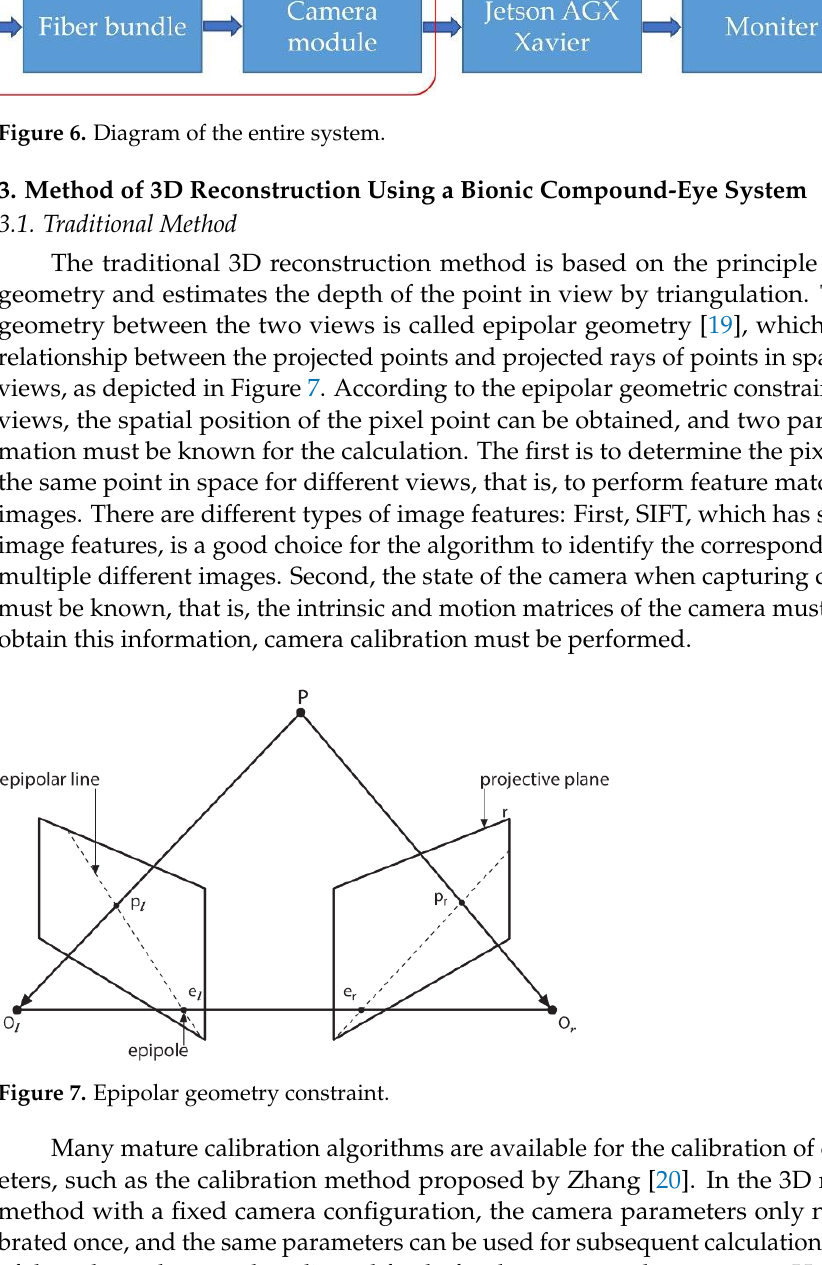
Figure 5. NVIDIA Jetson AGX Xavier Developer Kit.